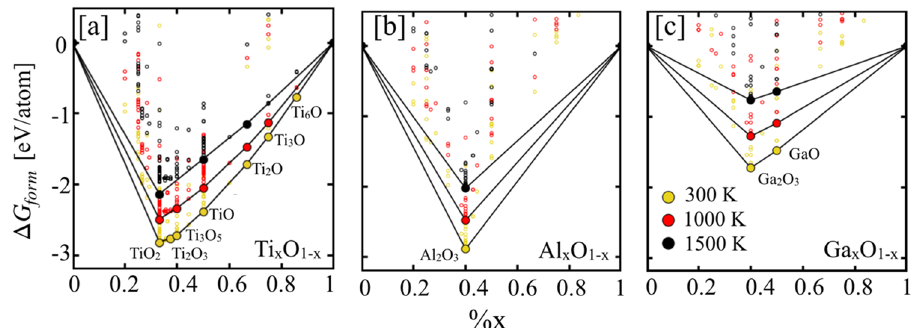
Figure 4. The temperature dependent convex hull of ( a ) Ti x O 1−x , ( b ) Al x O 1−x , and ( c ) Ga x O 1−x shows the higher stability (Gibbs formation enthalpy) of key oxide phases TiO 2 , Al 2 O 3 and Ga 2 O 3 , which is in agreement with phases present NIST-JANAF thermochemical table 54,58 .